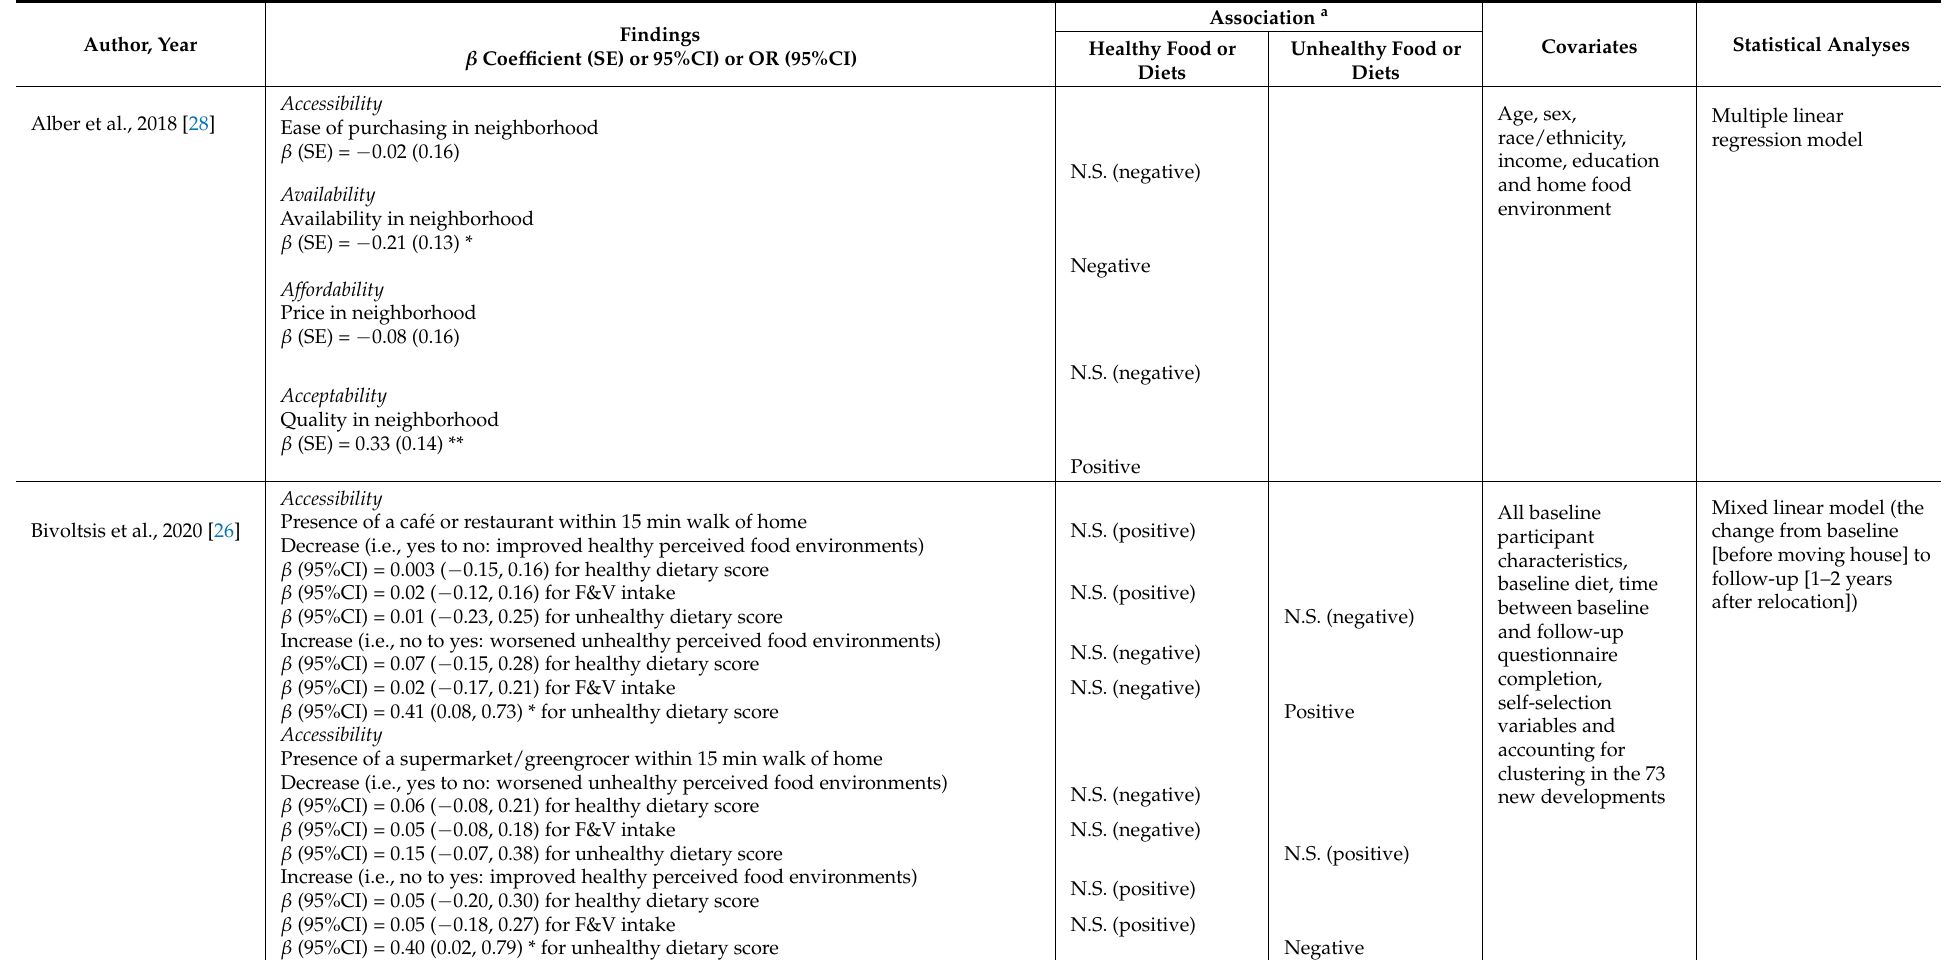
Table 4. Findings and statistical analyses of the association of perceived food environments with dietary food or